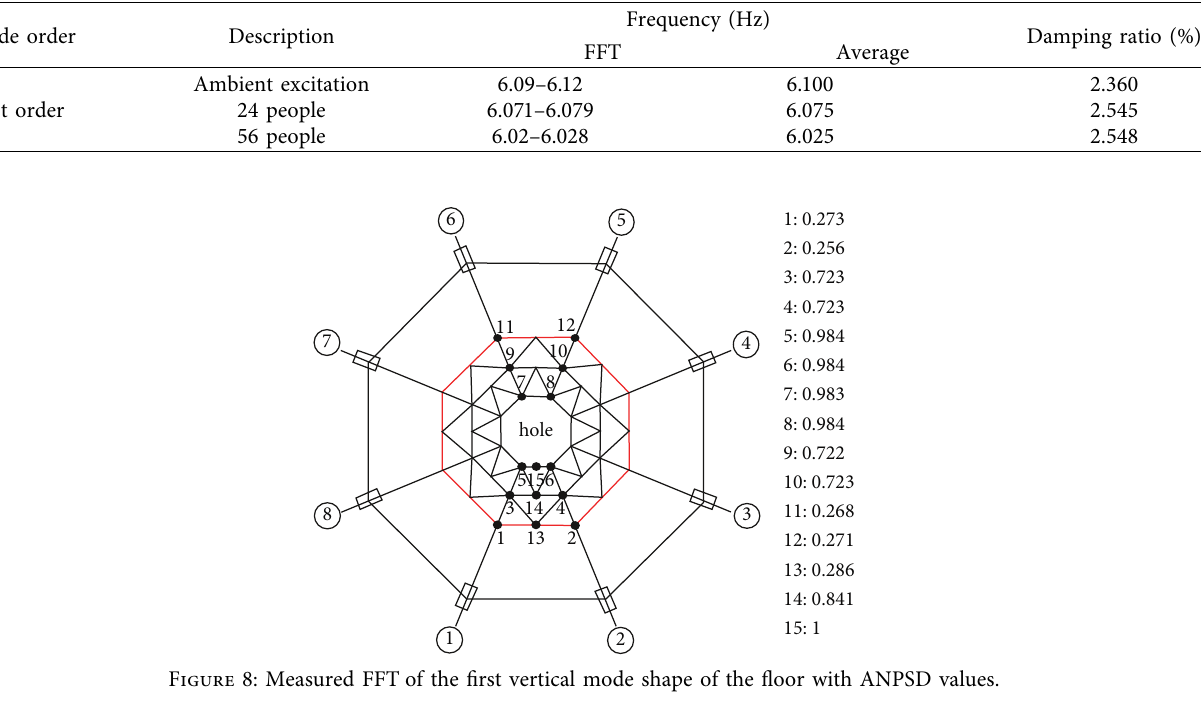
Table 2: Measured vertical frequencies and damping ratios of the floor.